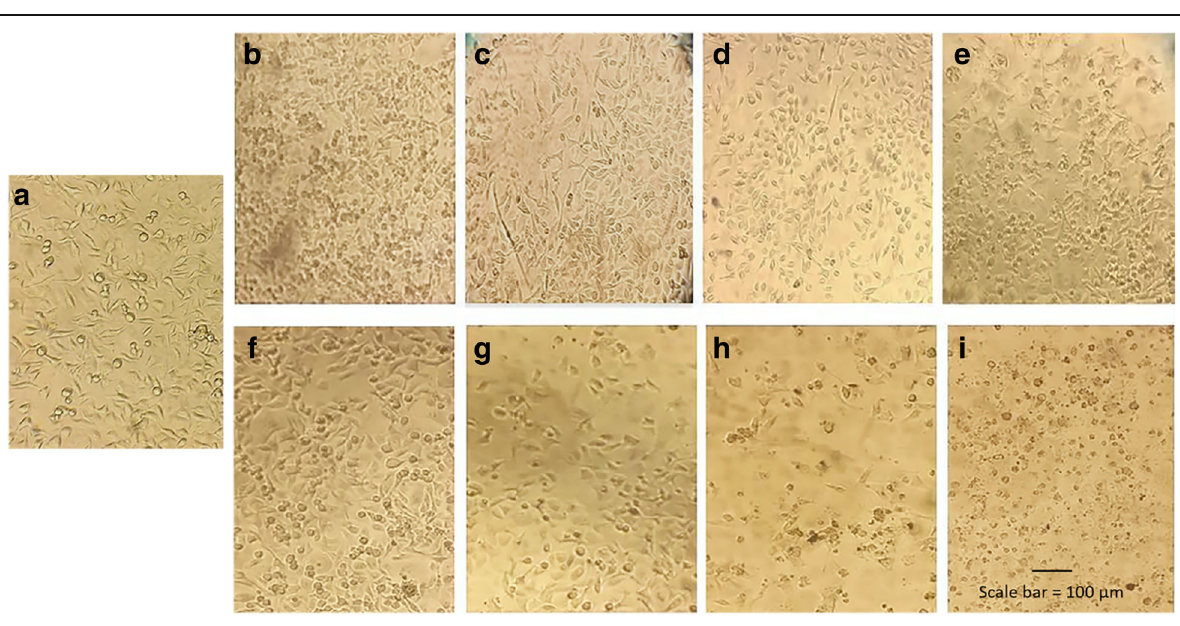
Fig. 8 Light microscope image (× 10) of cells treated with GNRs. HeLa-untreated cells ( a ), HeLa treated by 1 nM of CTAB-GNRs ( b ), 5 nM of CTAB- GNARs ( c ), 25 nM of CTAB-GNARs ( d ) and 125 nM of CTAB-GNARs ( e ) with less viability, and 1 nM of peptide-f-GNRs ( f ), 5 nM of peptide-f-GNRs ( g ), 25 nM of peptide-f-GNRs ( h ), and 125 nM of peptide-f-GNRs ( i ) with more viability. The cell density decreased, and the morphology changed in CTAB-GNR-treated cells in comparison with cells treated with